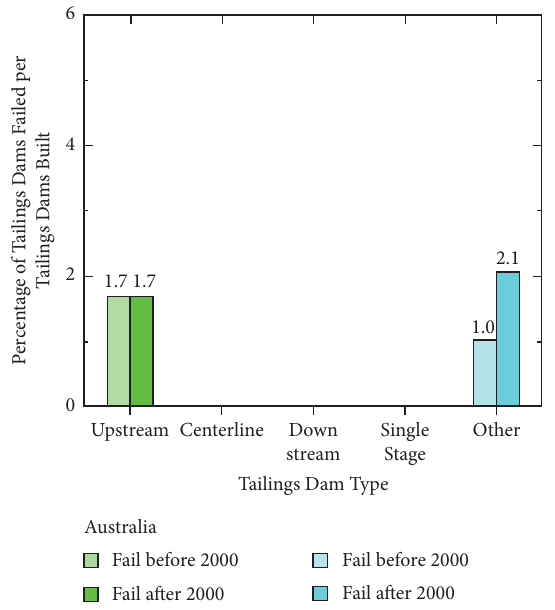
Figure 10: Percentage of tailings dams failed per tailings dams built in Australia, before and after 2000, according to dam type (data from GRID-Arendal [25] and Bowker